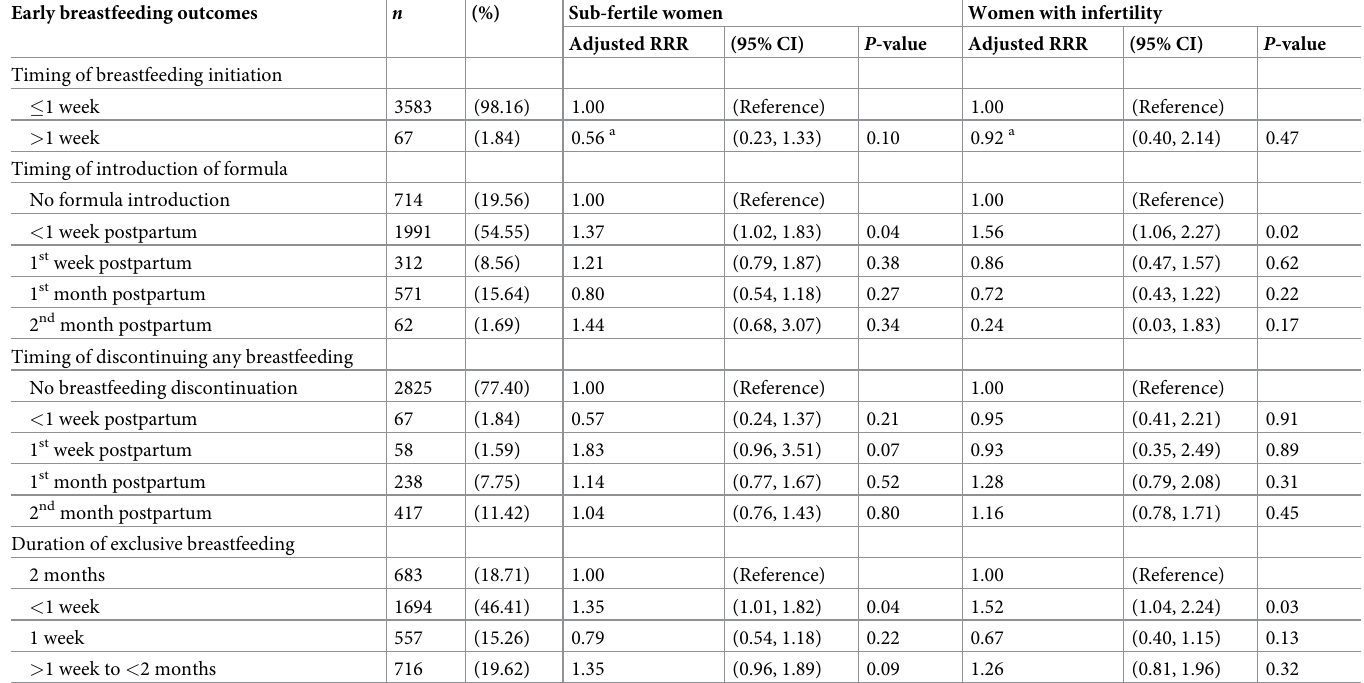
Table 2. Association between mode of conception and early breastfeeding outcomes (N =